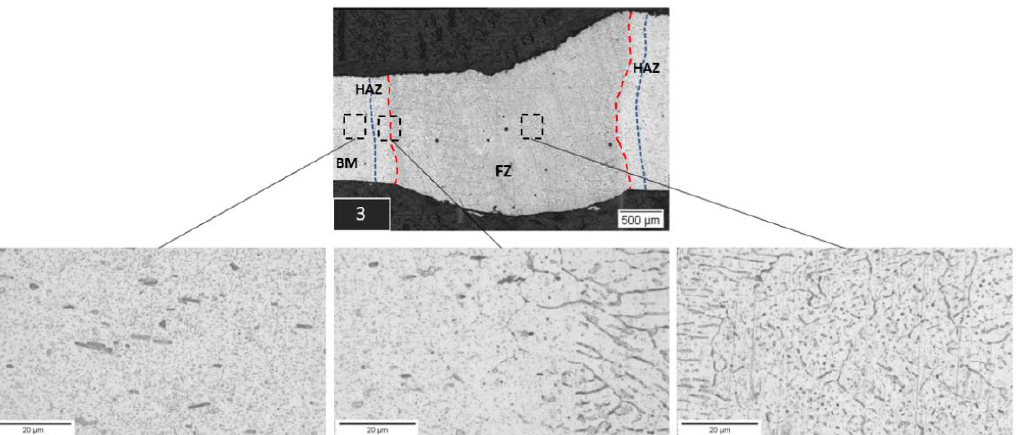
Figure 3. Typical metallographic cross-section of the welded joints and microstructure of the fusion zone, HAZ, and base material.